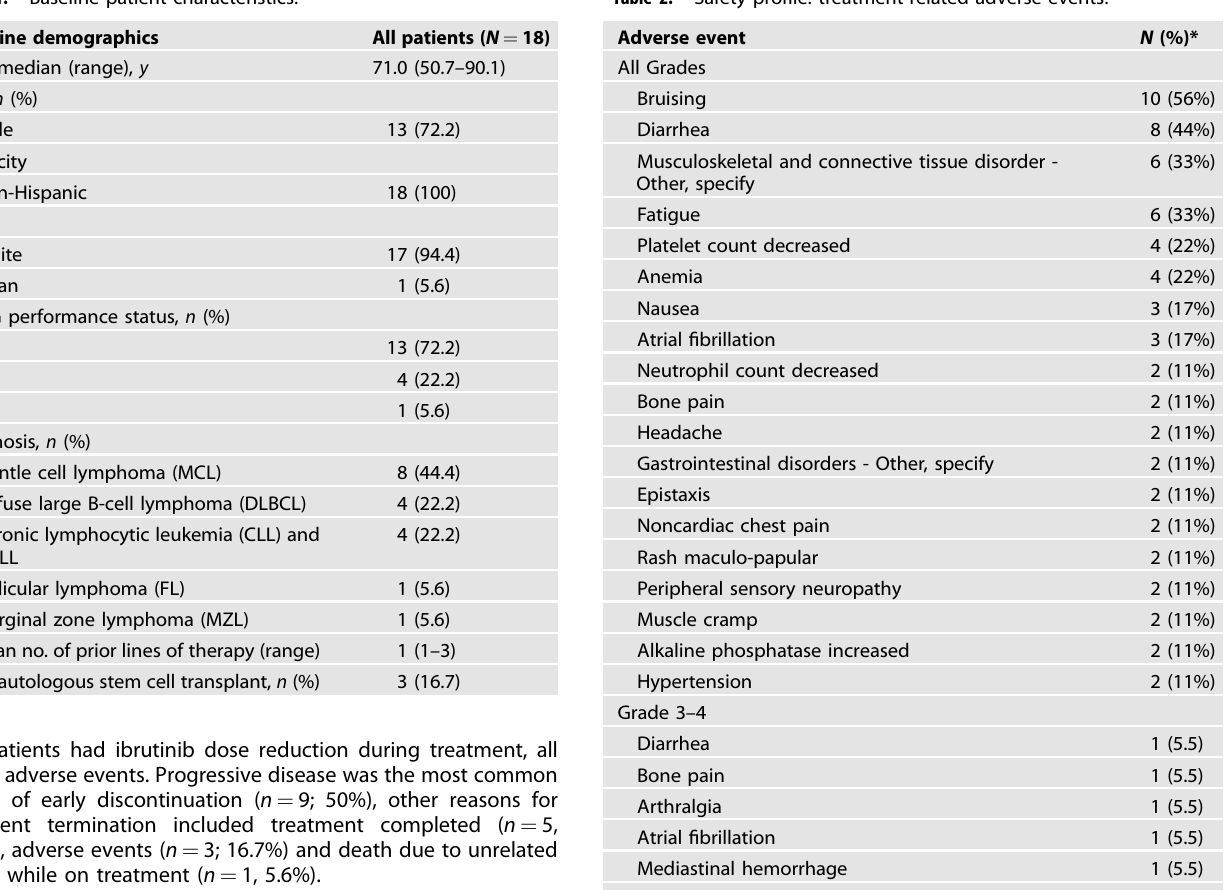
Table 1. Baseline patient characteristics. Table 2. Safety pro fi le: treatment-related adverse